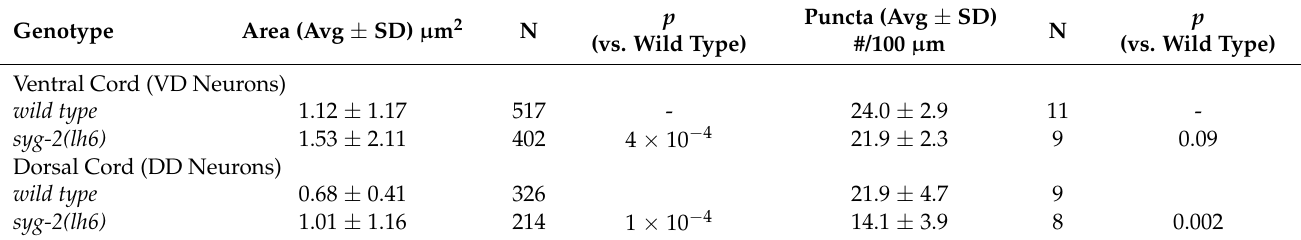
Figure 6. syg-2 mutants have fewer DD synapses. ( A ) The DD neurons form presynaptic puncta (illustrated by green circles) along the dorsal nerve cord. ( B ) In the wild-type dorsal nerve cord, synaptic puncta are regularly sized and spaced along the neuron process. ( C , D ) In lh6 ( C ) or ky673 ( D ) animals, fewer synaptic puncta are formed, with gaps and irregular spacing. ( E ) VD neurons form puncta along the ventral nerve cord. ( F ) A wild-type ventral nerve cord. ( G , H ) In the synapses formed in lh6 ( G ) or ky673 ( H ), the number of synapses is roughly equivalent to the wild type. Table 4. Synaptic measurements.